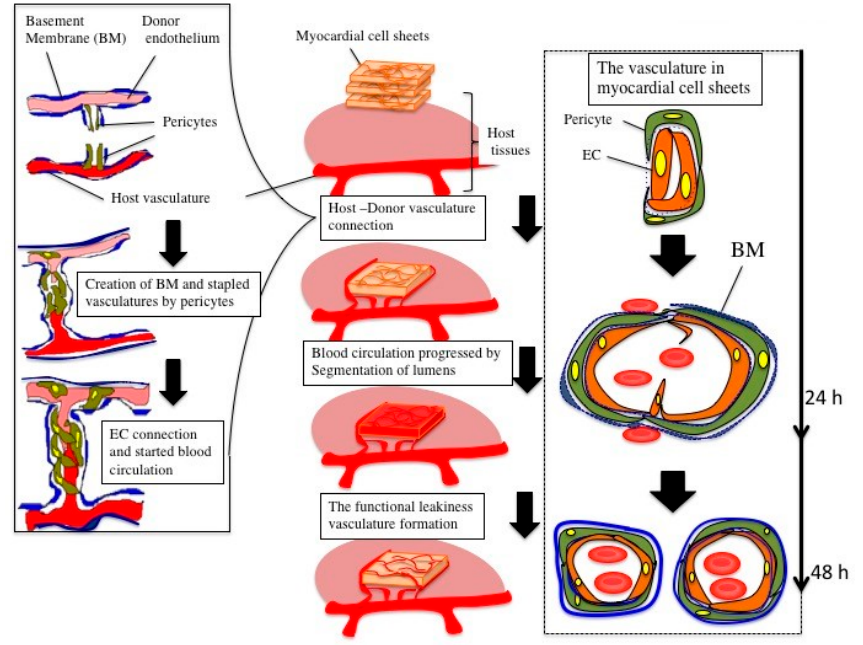
Figure 6. Hypothesis regarding connection and circulation process following engineered myocardial tissue transplantation into